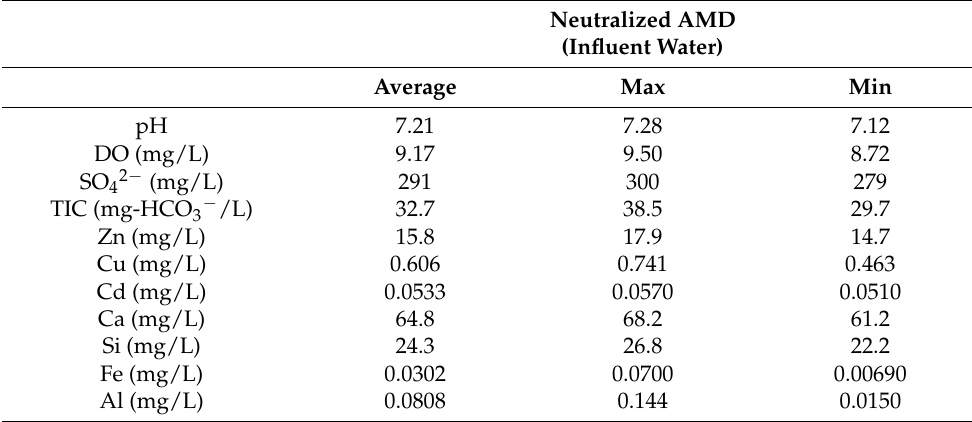
Table 1. Chemical composition of neutralized AMD used for the column test (average, maximum, and minimum values of 22 samples).